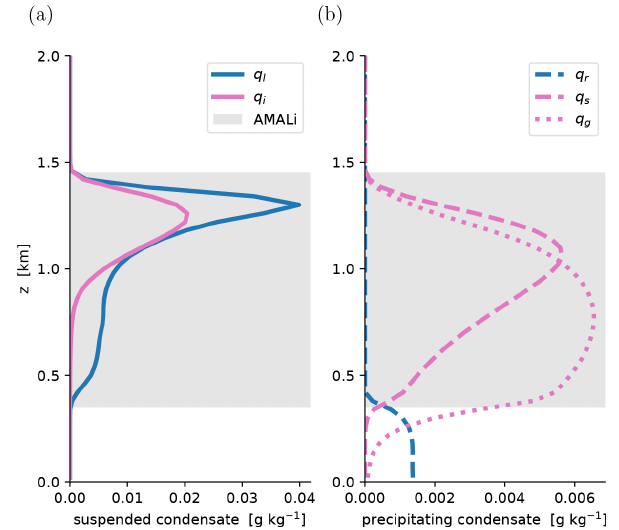
Figure 8. The specific masses of all five hydrometeor species in the control simulation at t = 24h. (a) Suspended species, including liquid water q l and ice water q i . (b) Precipitating species, including rain q r , snow q s , and graupel q g . Liquid species are shown in blue; frozen species are shown in pink. The vertical range of AMALi cloud top heights sampled within the target domain as shown in Fig. 2 is shaded